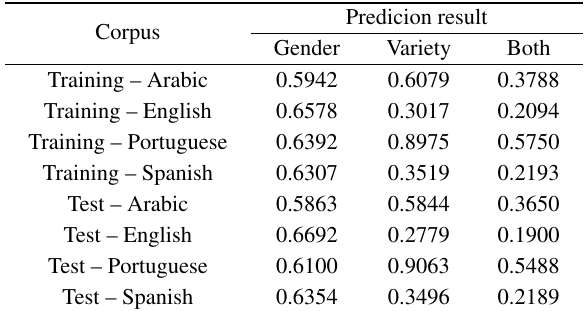
Table 7 Results of using 10-fold cross validation to predict gender, language variety, and both by Khan [44]